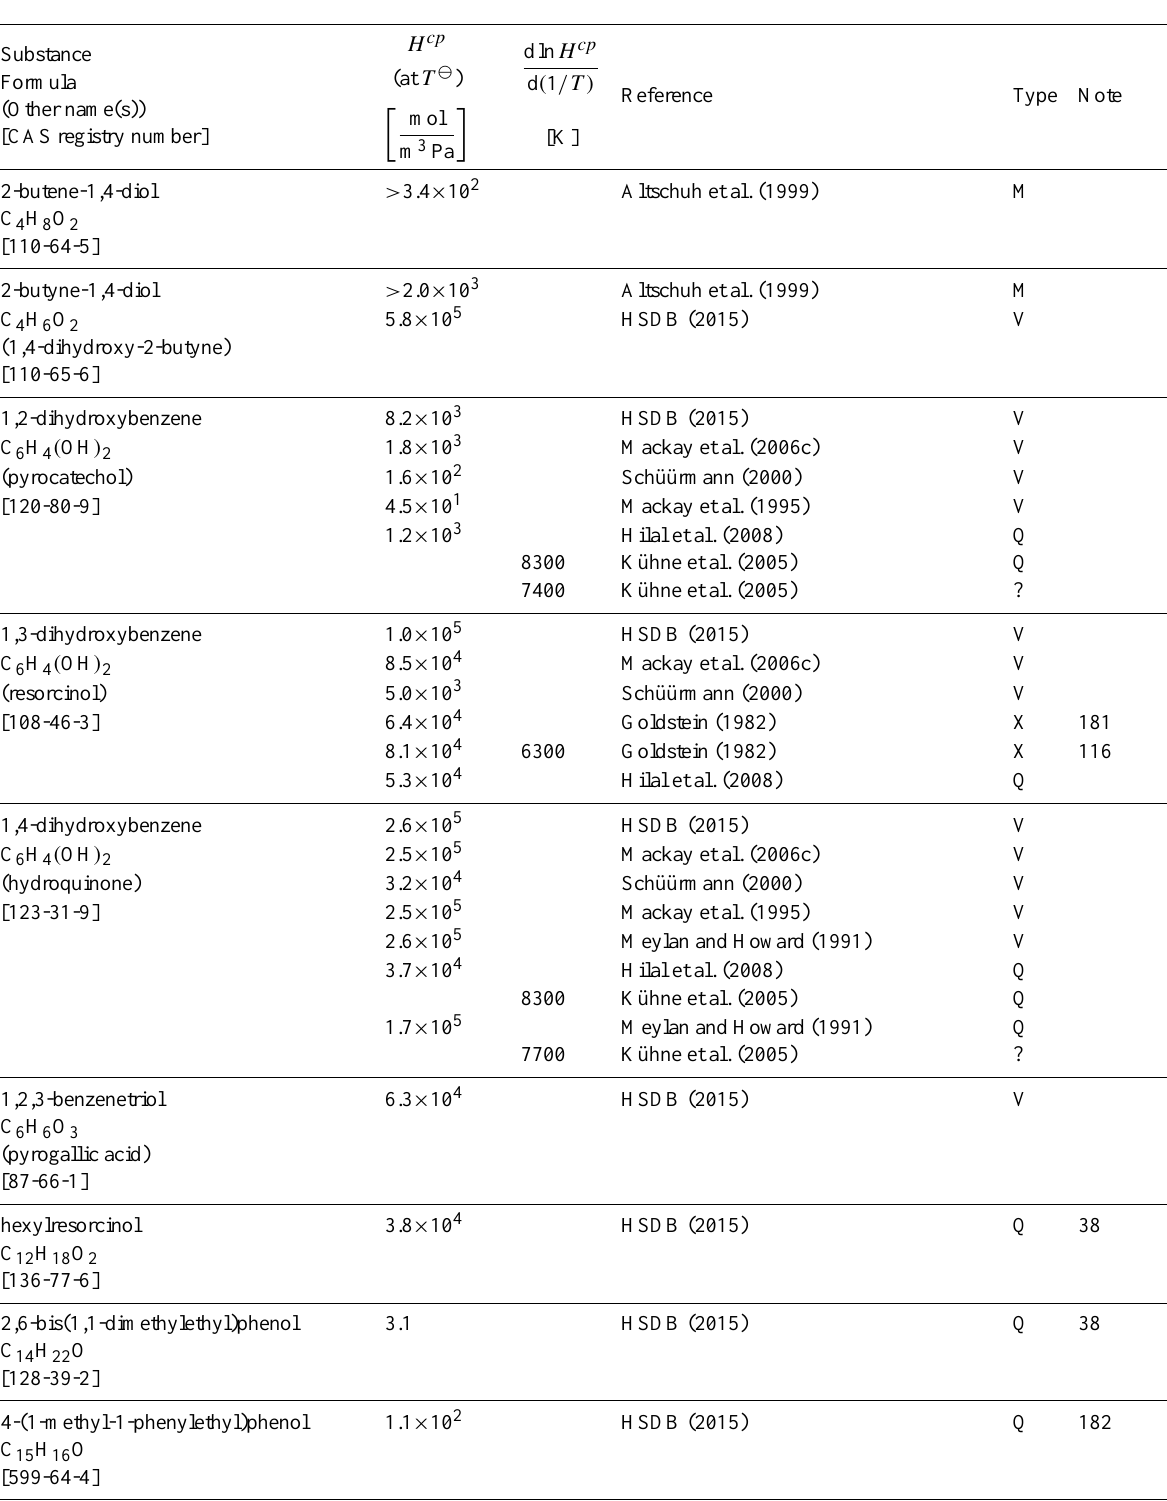
Table 6: Henry’s law constants for water as solvent